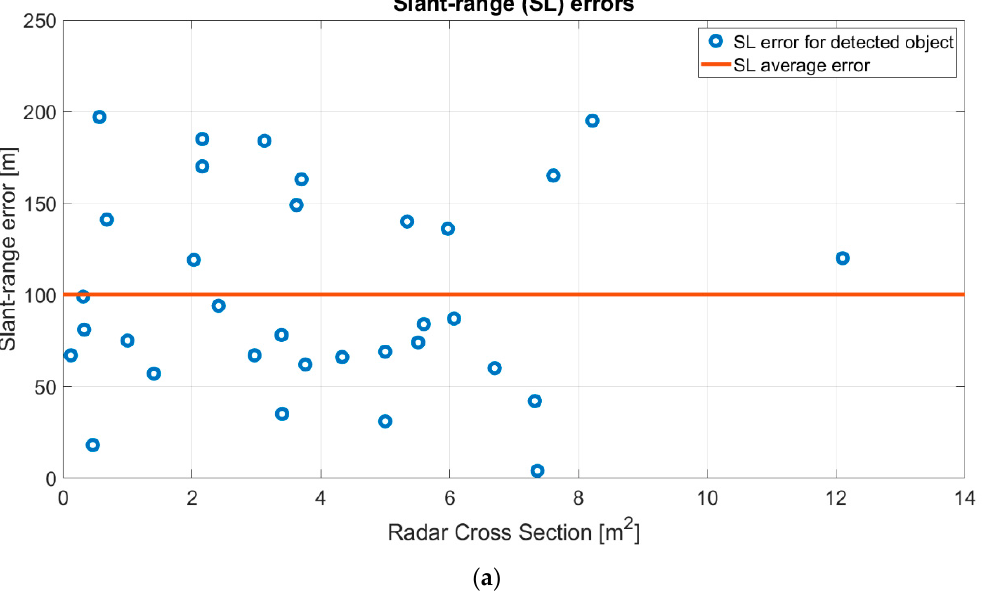
( b ) Figure 12. Measurement errors respect to estimated values: ( a ) slant-range error for each debris (blue points) and slant- range average error for all debris, equal to 100.189 m (red line); ( b ) Doppler shift error for each debris (blue points) and average error for all objects, equal to 37.95 Hz (red line). 6. Conclusions and Future Work